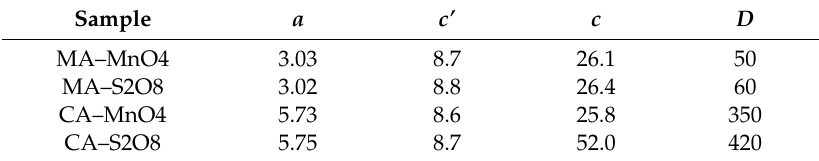
Table 2. Lattice parameters (Å) and average crystallite size ( D , Å) of the synthesised